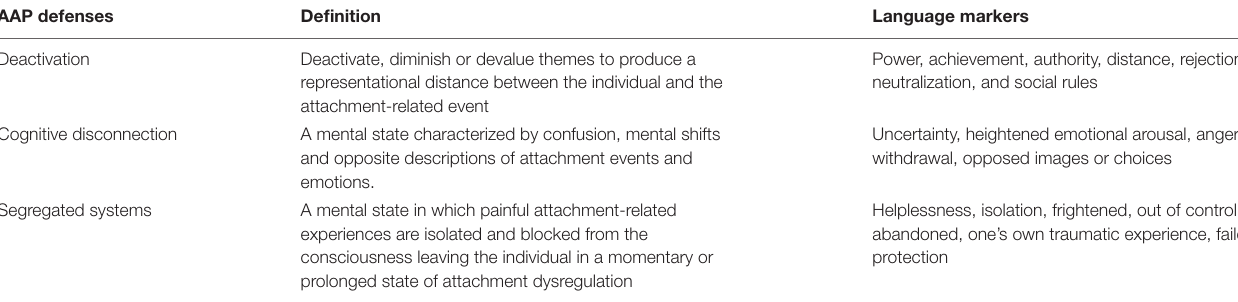
TABLE 2 | Overview on the defenses assessed with the Adult Attachment Projective Picture System (AAP). AAP